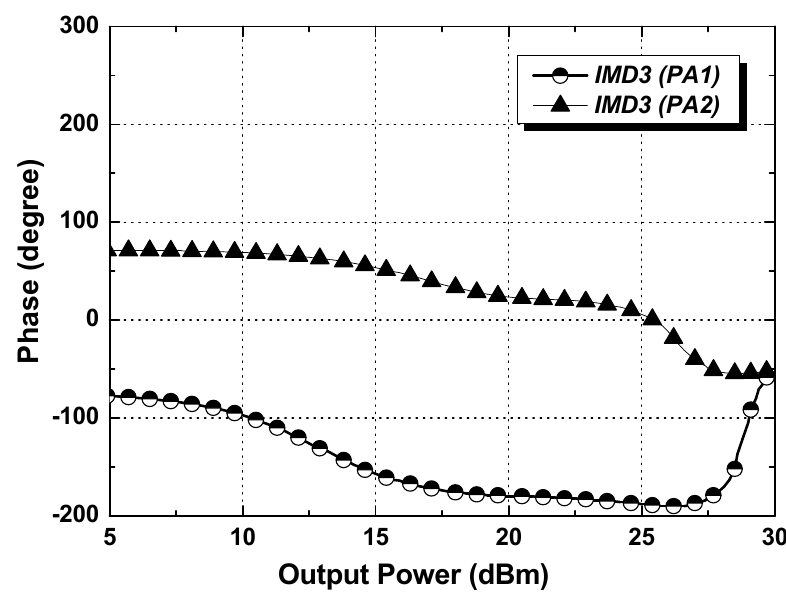
Figure 9. Two-tone simulated results for the phase of IMD3 currents. The phase difference in IMD3 currents between PA1 and PA2 is in the range of 180 ◦ ± 40 ◦ for an output power of up to 27.3 dBm. As shown in Figure 6, when the phase of the IMD3 currents from PA1 and PA2 is close to 180 ◦ out-of-phase, the IMD3 currents will cancel each other out at the output. Figure 10 shows the IMD3 comparison between the condition with IMD3 cancellation and that without the IMD3 cancellation under identical values of R b , R b1 , and C b1 . For the case of the PA without the IMD3 cancellation, the condition of R b,PA1 = R b,PA2 , R b1,PA1 = R b1,PA2 , and C b1,PA1 = C b1,PA2 is chosen. An IMD3 performance of − 40 dBc can be maintained for an output power of up to 28.1 dBm by applying the IMD3 cancellation condition.